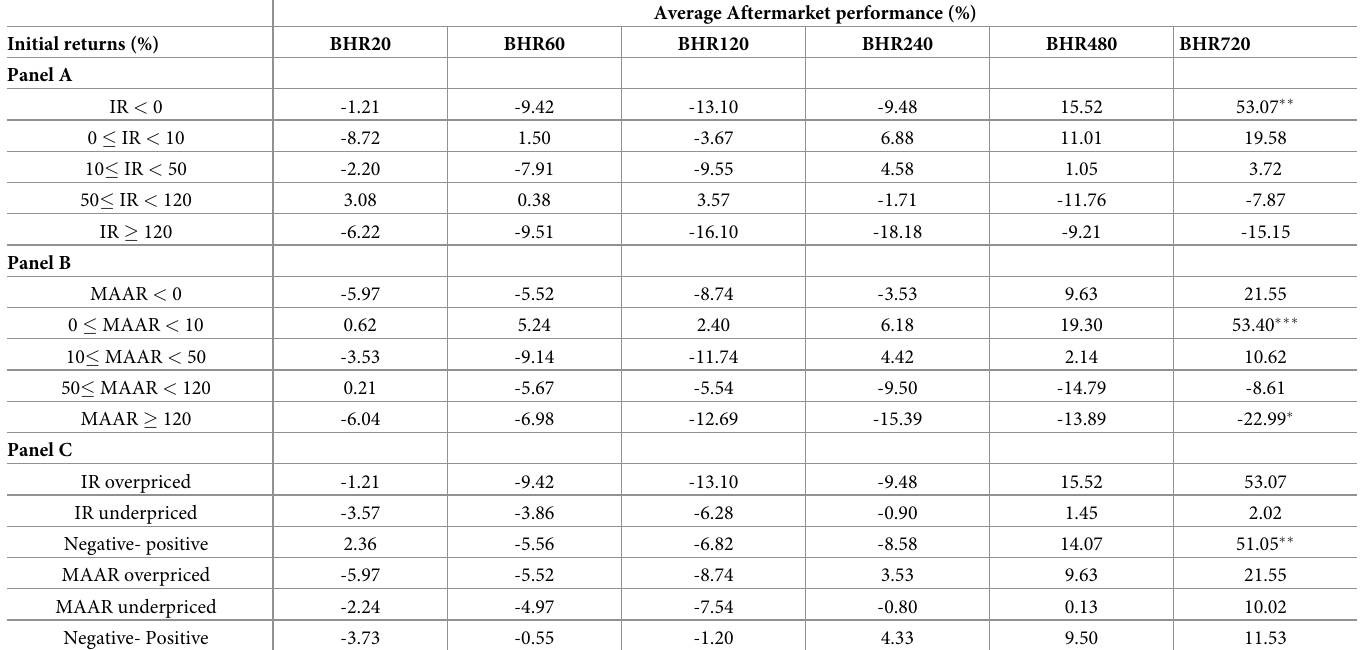
Table 3. Aftermarket performance categorized by initial returns.